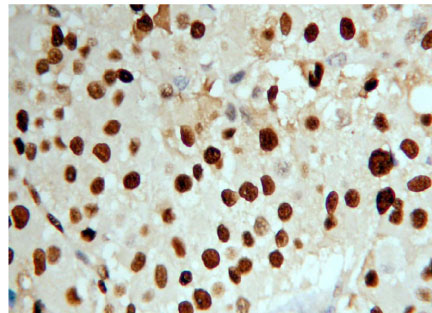
Adrenocortical carcinoma PCNA ( + + +) SuperisionTM two footworks